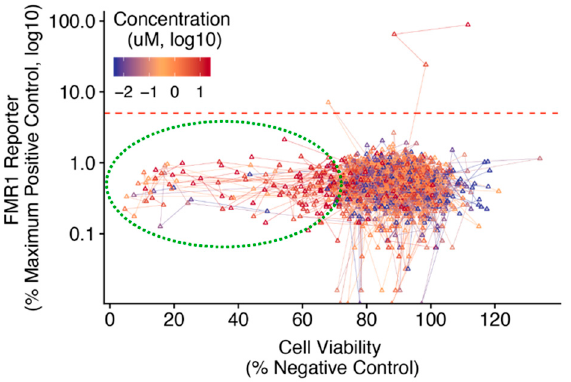
Figure 6. Confirmatory validation screen of candidate molecule dose-response characteristics of both FMR1 reporter response and cell viability in FXS neural progenitor cells. FXS reporter neural progenitor cells (NPCs) were treated with secondary screen candidate molecules for 72 h. Mean cell viability ( x -axis) is plotted against mean FMR1 reporter activity ( y -axis) across a range of treatment concentrations (color scale). Results from each unique test molecule are connected with lines in order of increasing concentration. A response threshold of 5% mean 5-Aza-DC (positive control) activity was used to identify candidate molecules for follow-up analysis (red dashed line).